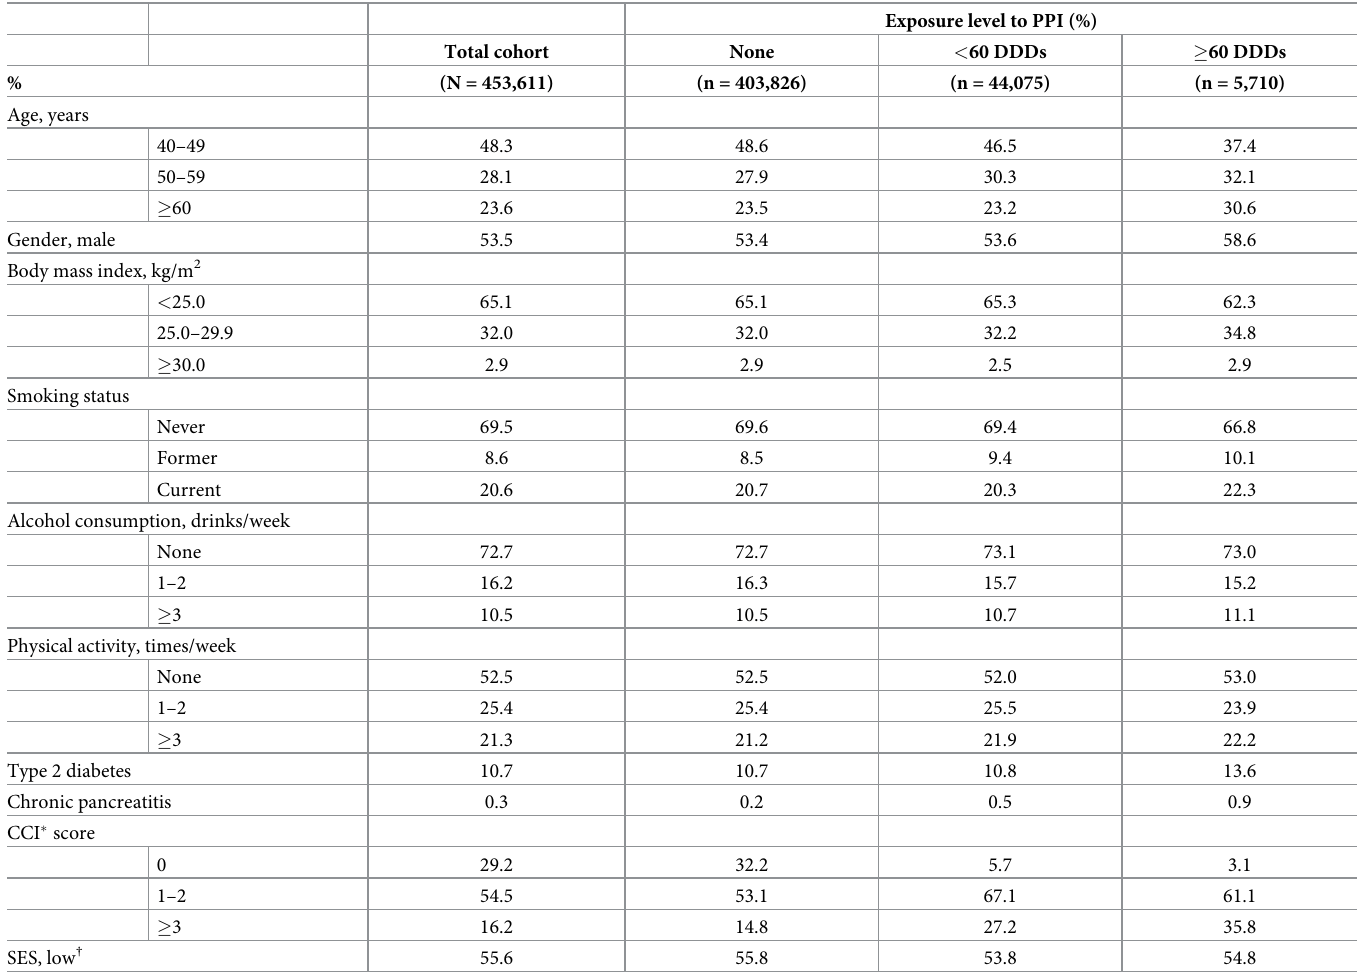
Table 1. Characteristics of the study population by PPI